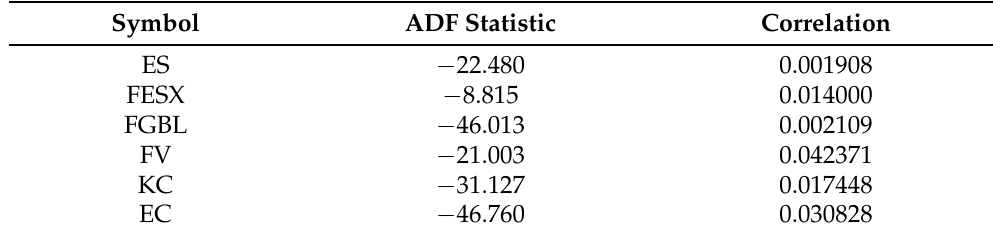
Table 1. First-order logarithmic differenced series ADF test results and correlation with original series. Symbol ADF Statistic